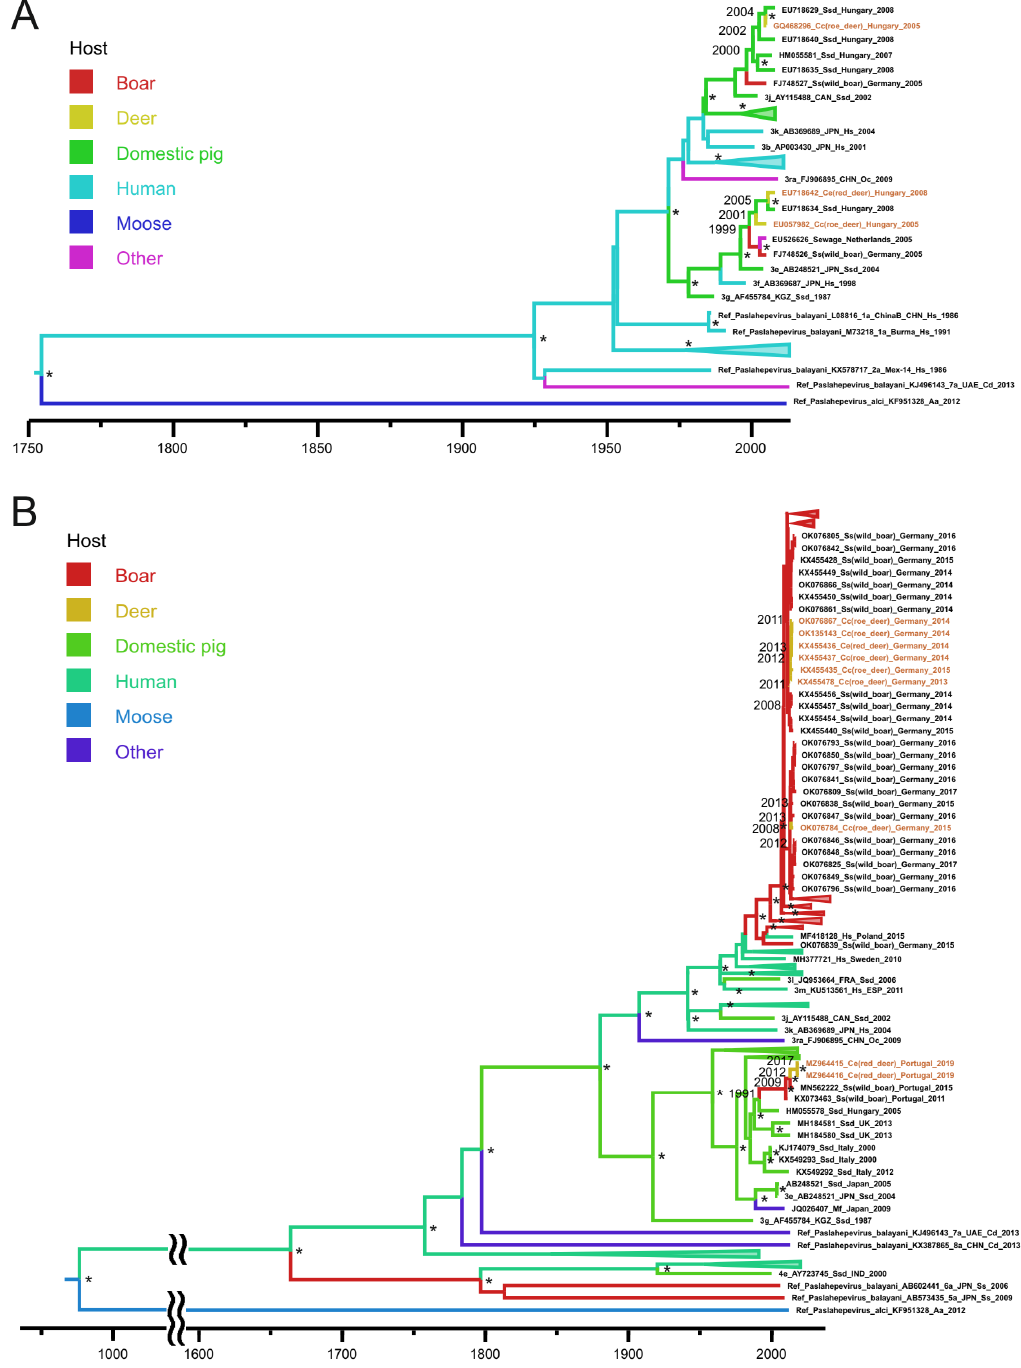
Figure 3. Bayesian phylogenetic trees based on 148 nucleotide ORF2 HEV sequences ( A ), and 280 nucleotide RdRp fragment of ORF1 HEV sequences ( B ), with indicated host range. The tree root was cut off to ensure the visibility of the modern parts of the tree. For each sequence, the number in the GenBank database, country (region), host organism, and the year of isolation are indicated. Host designations are as follows: Hs—human ( Homo sapiens ), Ssd—domestic pig ( Sus scrofa domesticus ), Ss—wild boar ( Sus scrofa ), Cc—roe deer ( Capreolus capreolus ), Ce—red deer ( Cervus elaphus ), Cn—sika deer ( Cervus nippon ), Oc—rabbit ( Oryctolagus cuniculus ), Mf—monkey ( Macaca fuscata ), Cd—camel are shown in brown. Tree nodes with posterior probabilities >90% are marked “*”. For key nodes, the calculated years of formation are indicated. The X axis shows chronological time expressed in